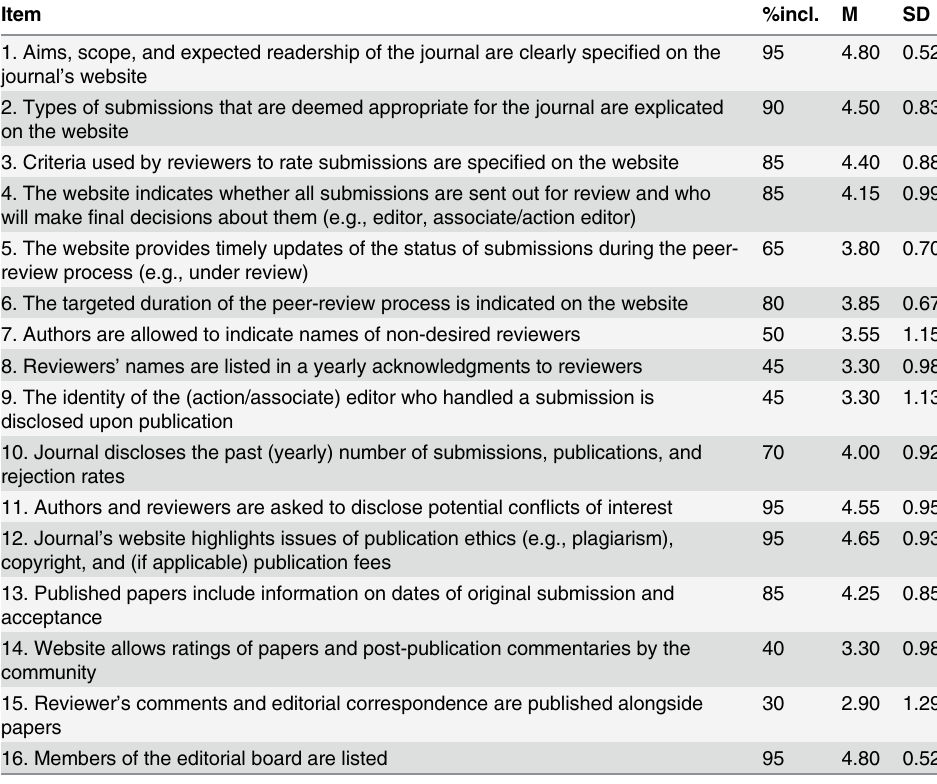
Table 3. Descriptive statistics of relevance ratings of the 16 questions in the original tool by 20 stake- holders (Study 2). Item %incl. M